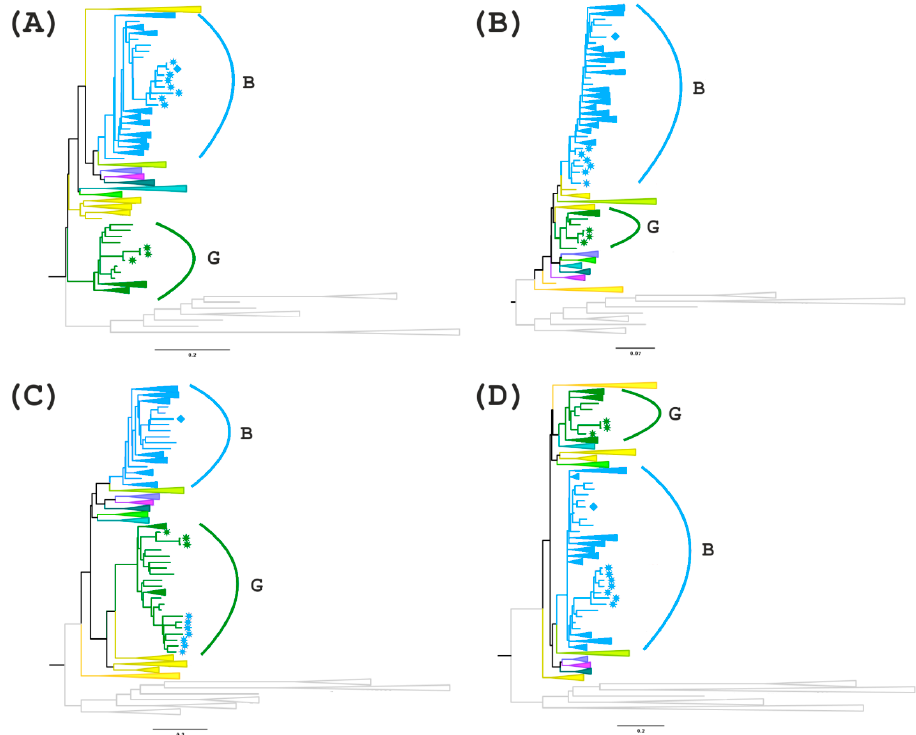
Figure 5. Phylogenetic trees for the nucleotide sequences of recombination regions I ( A ), III ( B ), IV ( C ) and V ( D ) of 11 genomes of subtypes G and BG. The B subtype is highlighted in blue and the G subtype is highlighted in green. BG recombinants are indicated with blue stars, except for MF614610. Sample MF614610 is indicated by a blue rhomb and the samples of subtype G from the outbreak are indicated by green stars.